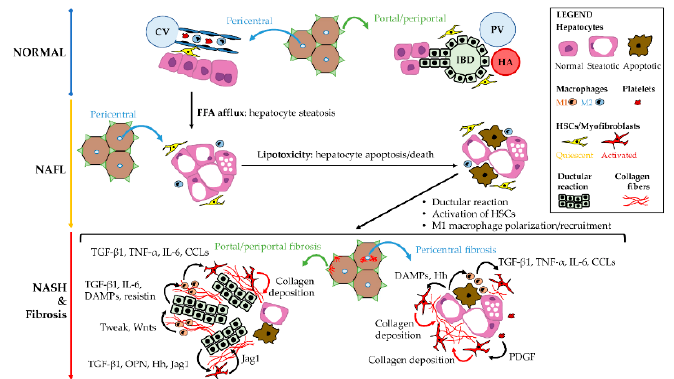
Figure 3. Cellular cross-talks in the pathogenesis of non-alcoholic fatty liver disease (NAFLD). The increase of free-fatty acid (FFA) afflux to the liver determinates hepatocyte steatosis (non-alcoholic fatty liver - NAFL); subsequently, the accumulation of abnormal lipid compounds in the hepatocytes causes lipotoxicity, leading to hepatocyte damage, apoptosis and death. Hepatocyte lipotoxicity triggers M1 macrophage recruitment and lobular inflammation (i.e., steatohepatitis: NASH) and, then, pro-fibrogenetic pathways. In pericentral zone, the activation of hepatic stellate cells (HSCs) and the M1 macrophage polarization trigger perisinusoidal fibrosis. At periportal location, ductular reaction emerges and drives the activation of local myofibroblast pools together with M1 macrophage recruitment. The main molecular factors implied in local cellular cross-talks are summarized in the